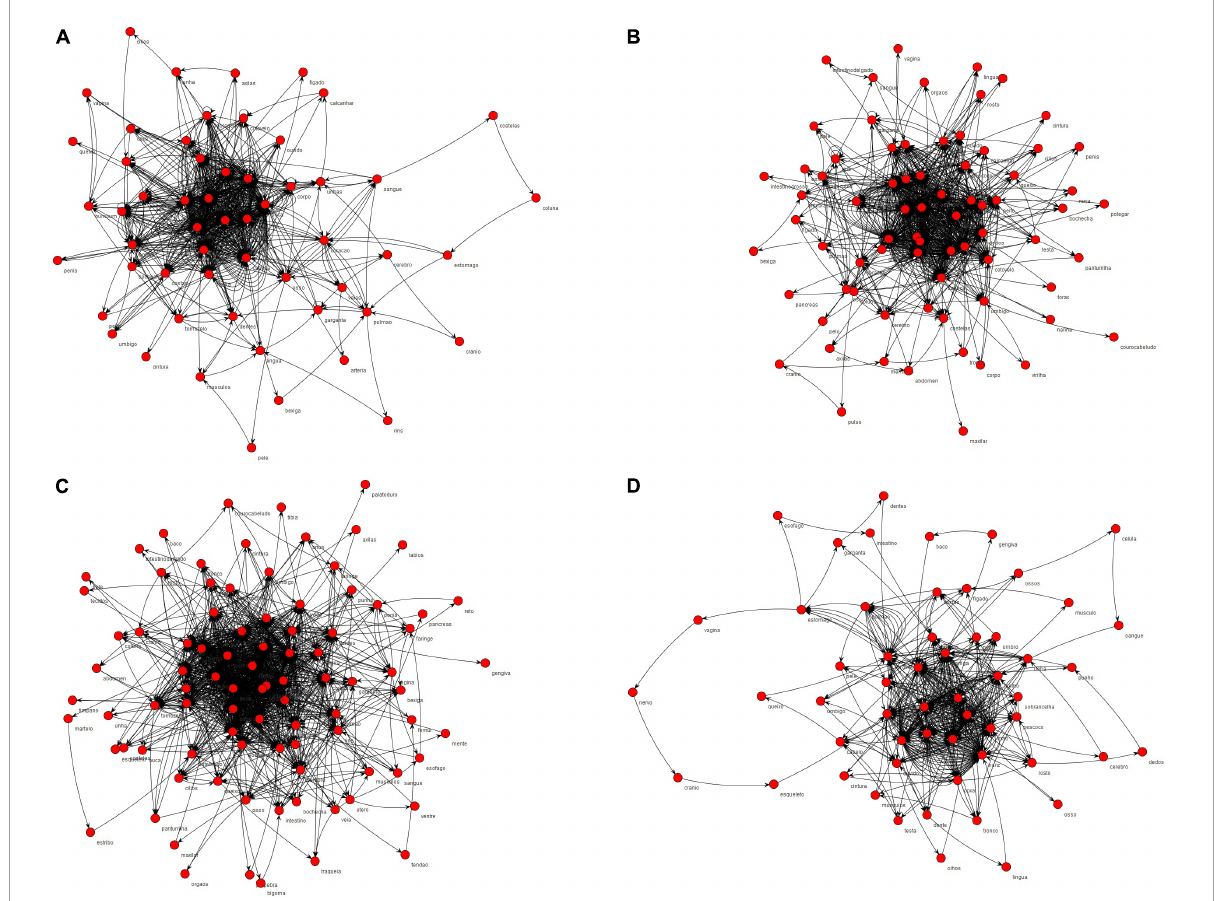
FIGURE1 Semantic networks of body parts category formed by the groups. In (A) semantic network formed by TD 4–6 years; (B) semantic network formed by TD 7–9 years; (C) semantic network formed by TD 10–12 years; (D) semantic network formed by HCP group.